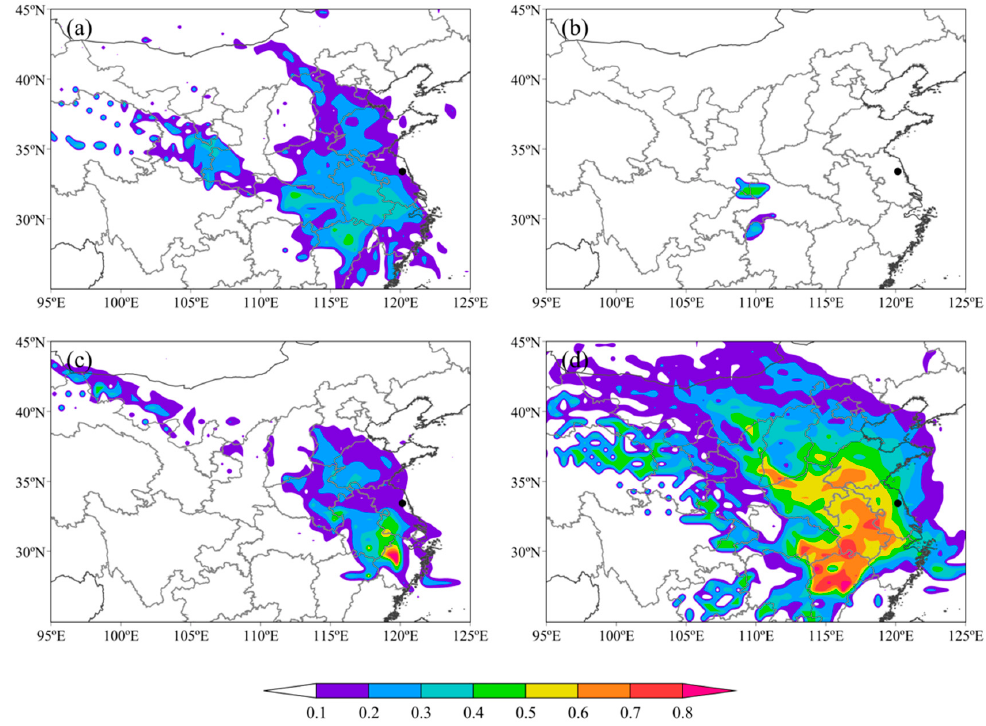
Figure 8. The distribution of the potential source contribution function (PSCF) on Yancheng during different season (( a ). Spring; ( b ). Summer; ( c ). Autumn; ( d ). Winter).